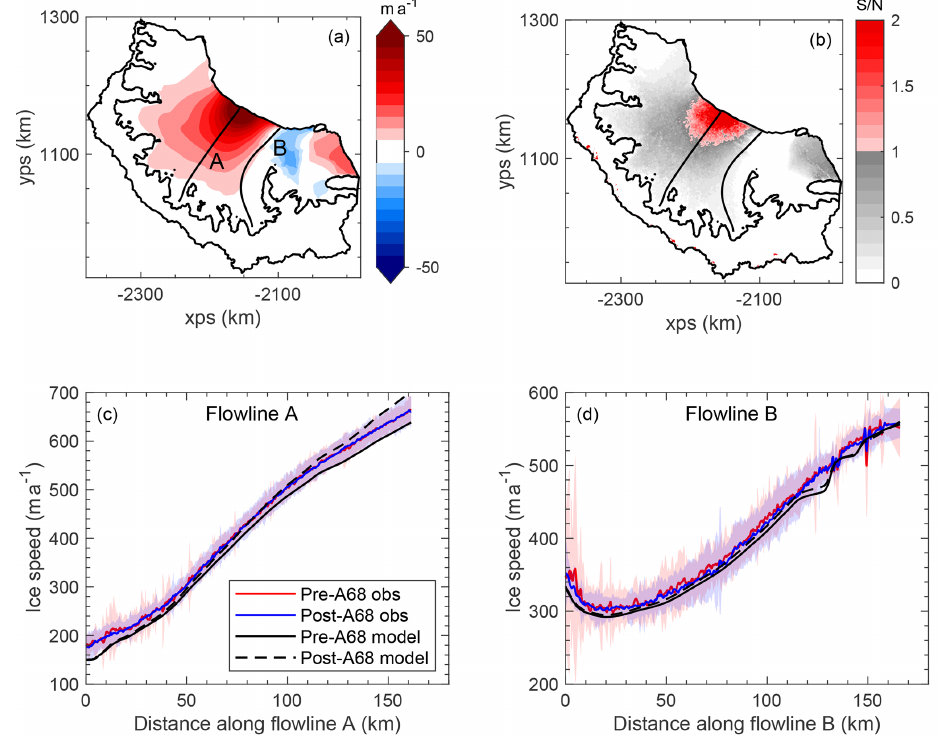
Figure 3. The modelled change in ice speed due to the calving of the A68 iceberg (a) along with the paths of the two flowlines used. Panel (b) is the ratio of the “signal” (model response in panel a ) to the “noise” (2 σ variability in the monthly observations of ice velocity). Panels (c) and (d) show the modelled ice speed before and after the calving event along two flowlines in the shelf. The mean observed speed before and after July 2017, together with shading representing the 2 σ variability, is also